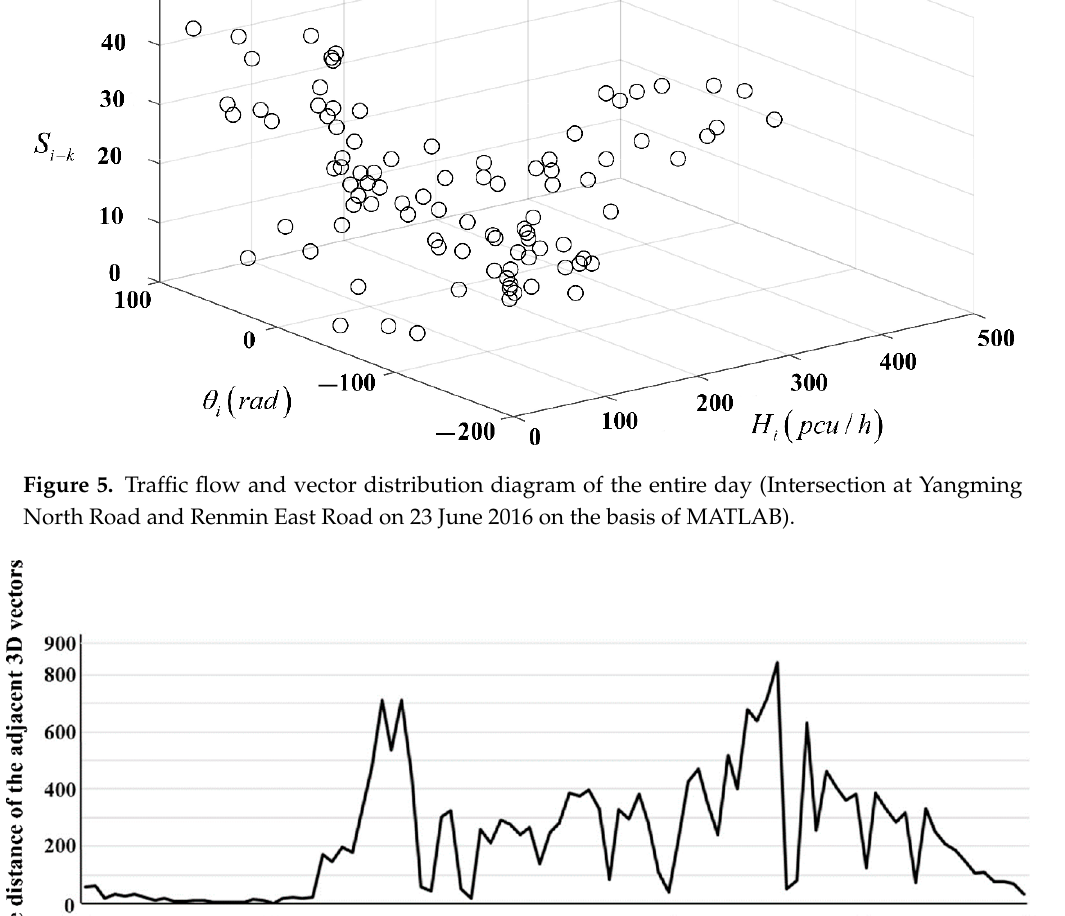
Figure 7. Scheme comparison diagram of the 3D vector time period division with the traditional total flow division (entire-day traffic flow at the intersection of Yangming North Road and Renmin East Road in Shaoxing on 23 June 2016).